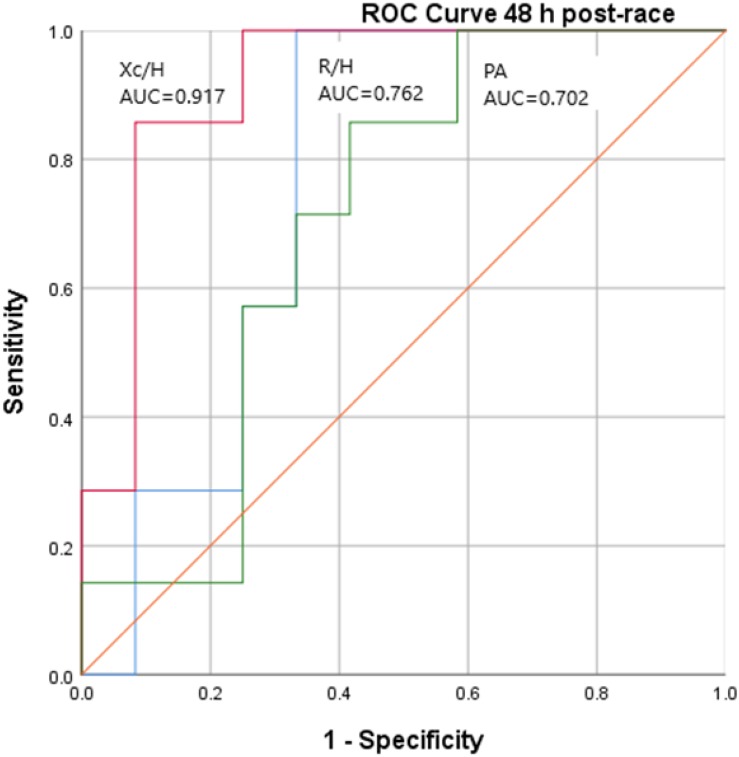
ROC Curve of R/H, Xc/H, and PA 48 h post-race according to cut-off of ≥1.2 mg/dL of serum creatinine post-race.